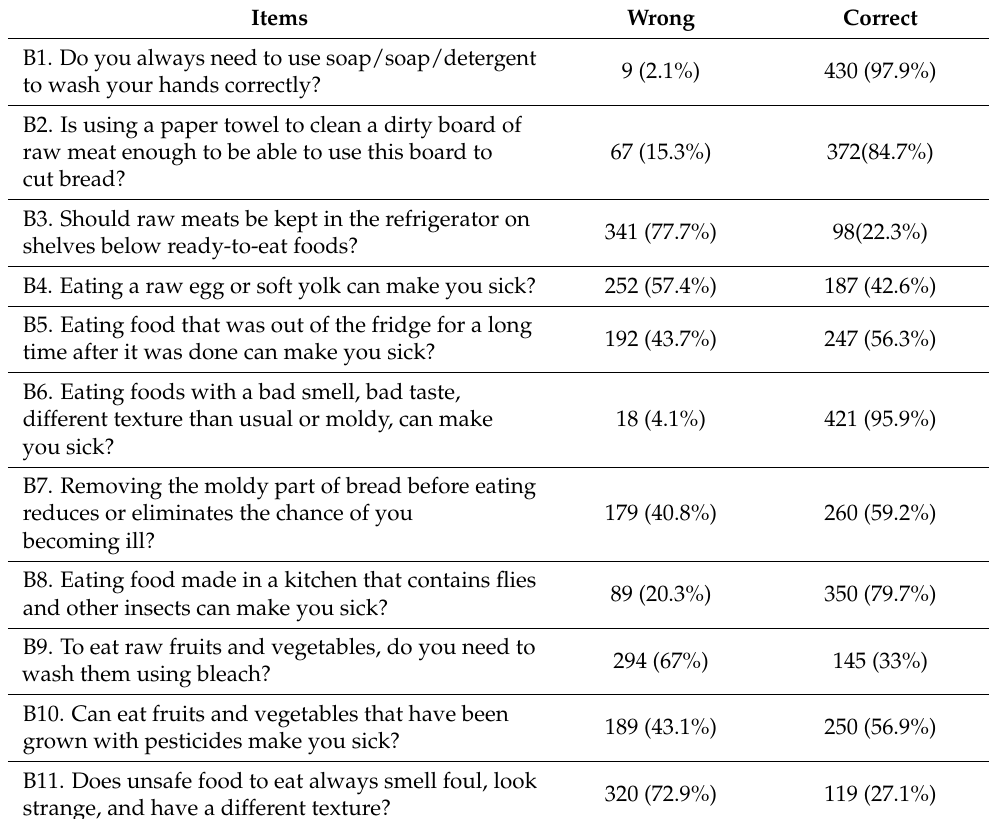
Table 4. Relative and absolute frequencies of responses to the knowledge